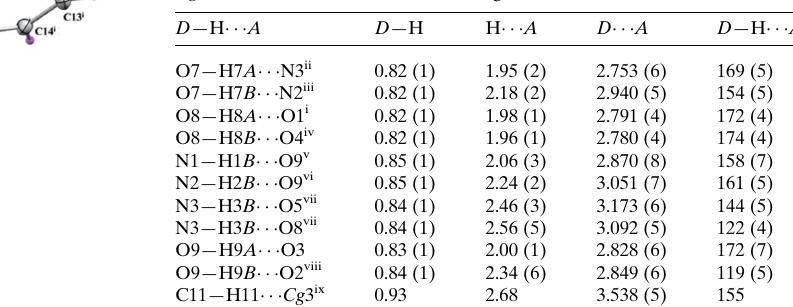
Table 2 Hydrogen-bond geometry (A˚ , (cid:3)